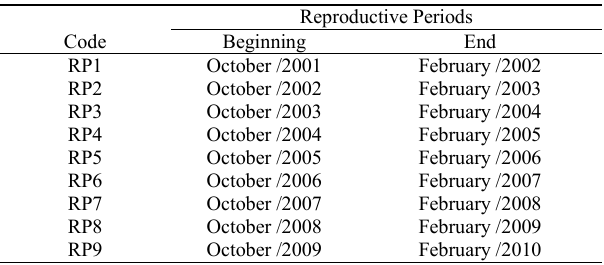
Table 1. Beginning and end of sampling during the different reproductive periods